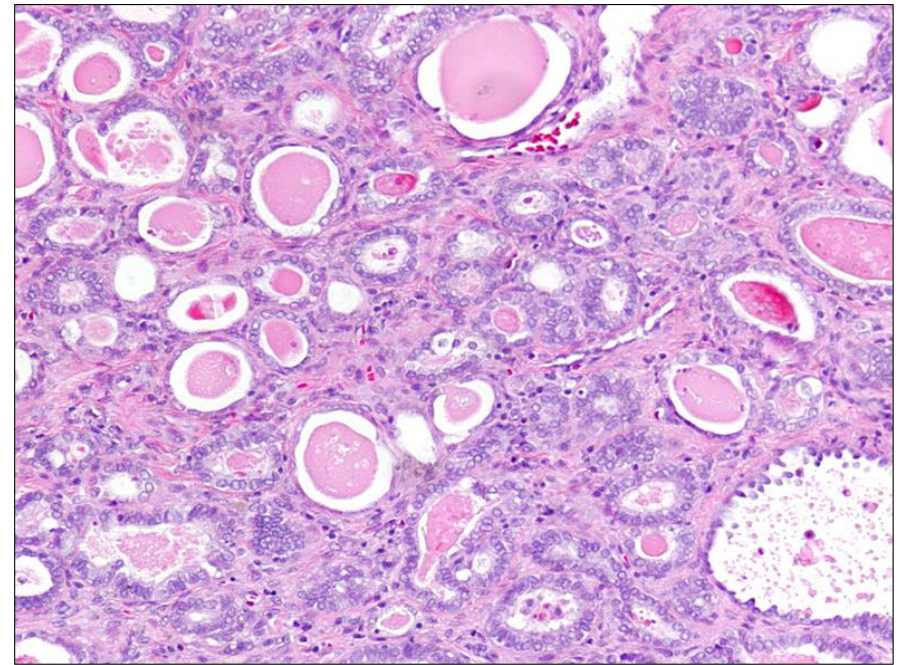
Figure 2. Mesonephric carcinoma, Hematoxylin-Eosin, 20 × magnification. This panel shows a typical mesonephric carcinoma composed of tubular glands lined by mucin-free cuboidal epithelium contain- ing eosinophilic, hyaline secretion in their lumina. Haphazard infiltrative growth, elevated mitotic activity, the presence of intraluminal cellular debris, and nuclear atypia are also peculiar features.